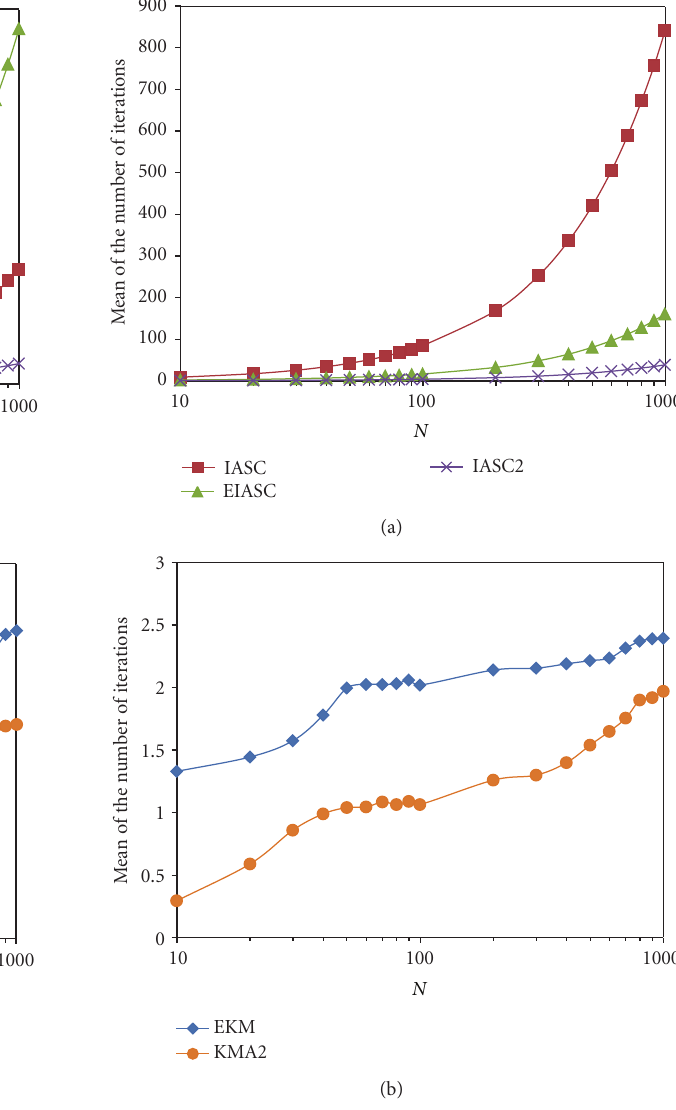
Figure 10: Right-sided random FOU, iterations, (a) IASC-type algorithms and (b) KM-type